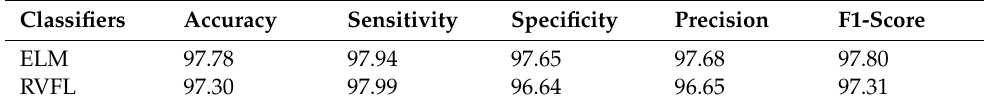
Table 7. Results of the CGENet using different classifiers based on 5-fold CV.